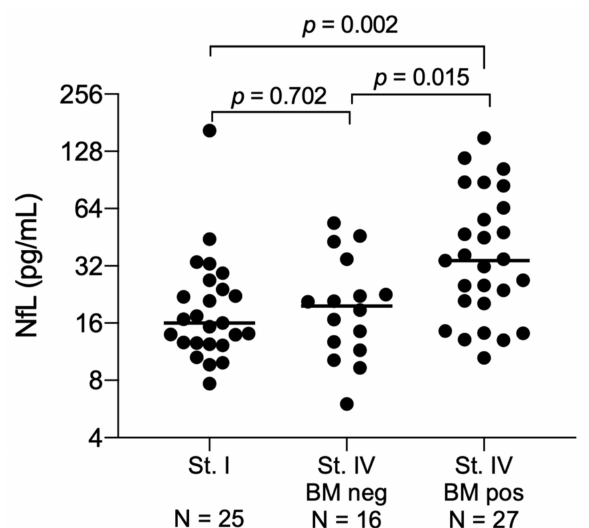
Figure 1. Neurofilament light chain levels at the time of lung cancer diagnosis. Patients are divided in stage I patients ( N = 25), stage IV patients without a brain metastasis at time of lung cancer diagnosis ( N = 16) and stage IV patients with a brain metastasis at time of lung cancer ( N = 27). Median values are marked for each group. Medians are compared by the Mann–Whitney rank sum. Abbreviation: NfL: Neurofilament light chain; St: Stage; BM; Brain metastasis; neg, negative; pos,